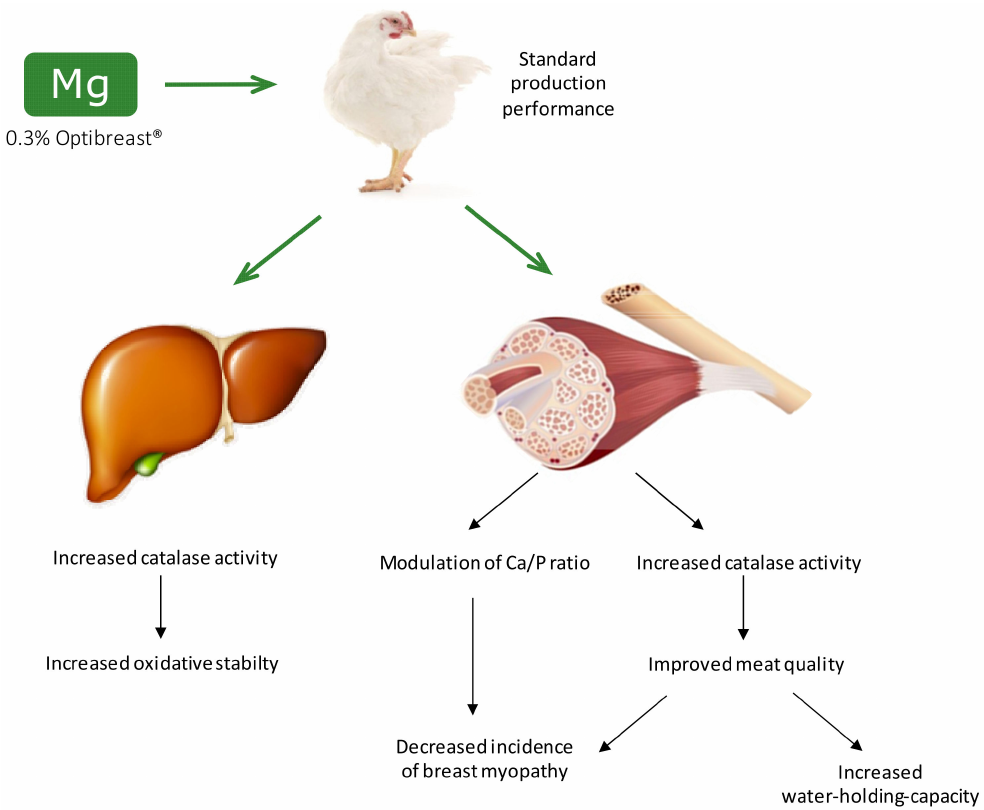
Figure 1. Graphical representation of main benefits of Mg supplementation on broiler redox-status, oxidative stability and meat